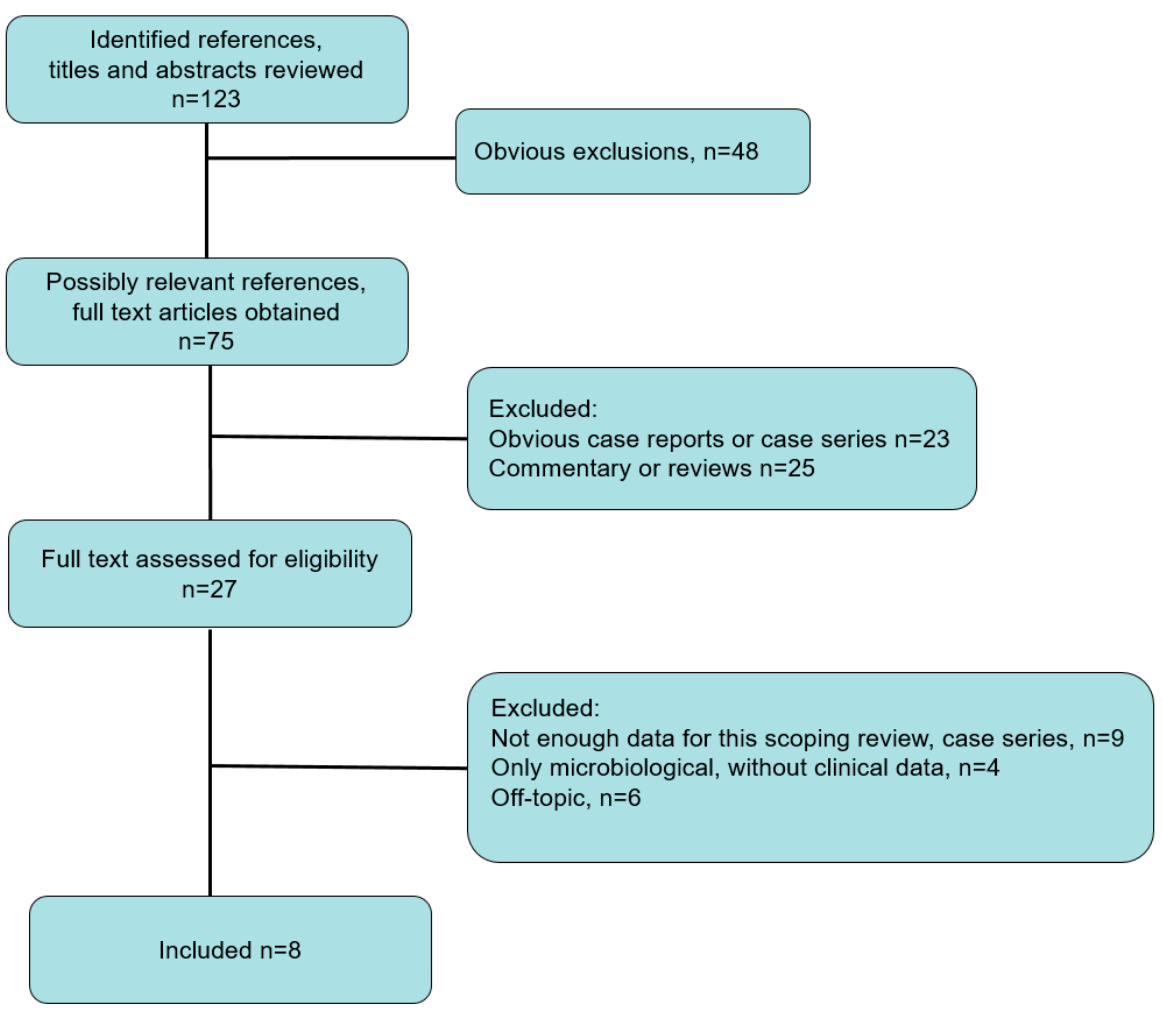
Figure 1. Literature flow.